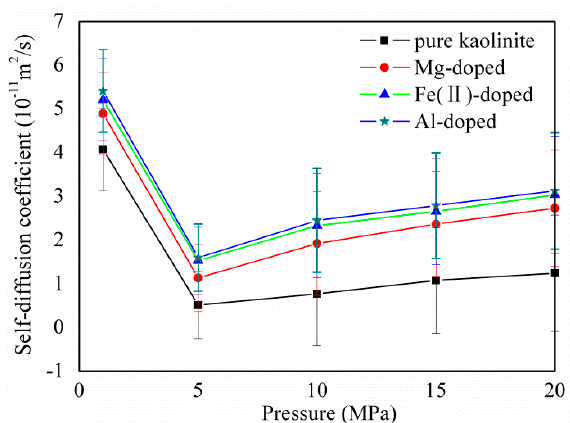
Figure 8. The self-diffusion coefficients of CH 4 on pure and Mg-, Fe(II)-, and Al-doped kaolinite at different pressures. Error bars indicate the standard deviations.